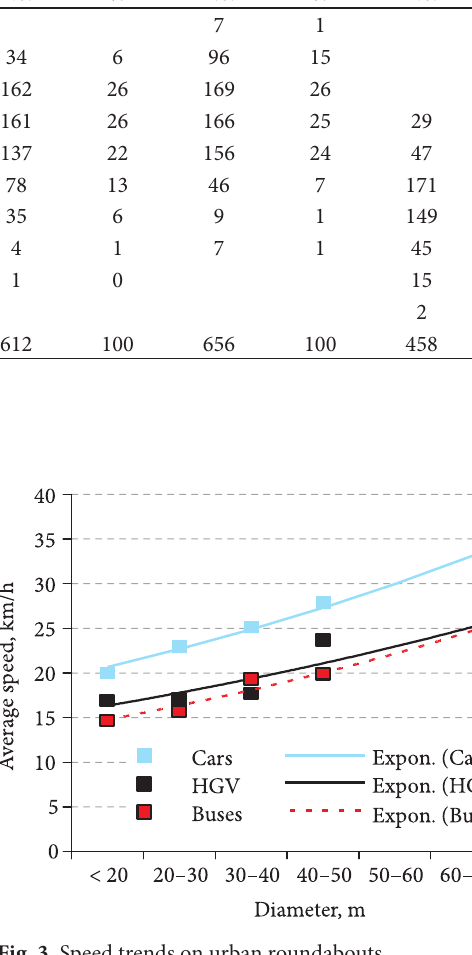
fig. 2 .Mean speed on roundabouts fig. 3. Speed trends on urban